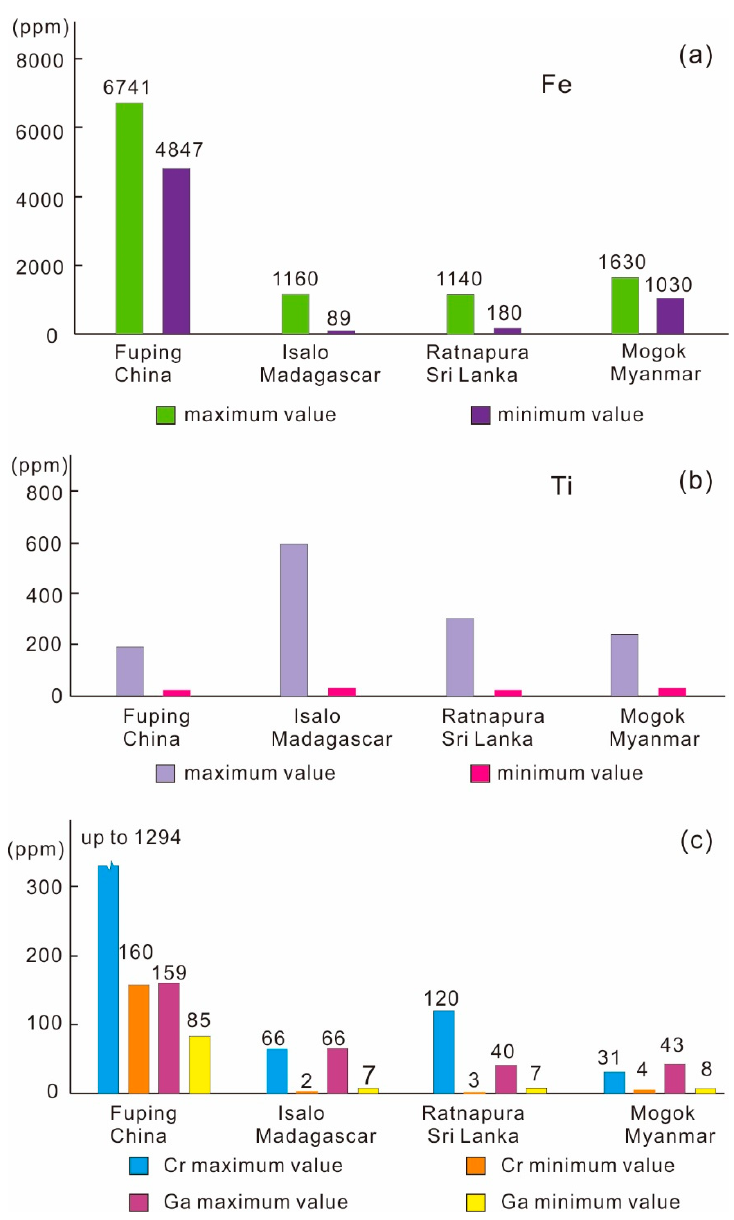
Figure 5. Comparison of trace element compositions of non-basalt-type sapphires. ( a ) Comparison of Fe element content; ( b ) Comparison of Ti element content; ( c ) Comparison of Cr and Ga contents. Note: Data of Fe, Ti, Cr and Ga elements of sapphires from Madagascar, Sri Lankan and Myanmar are taken from [39].